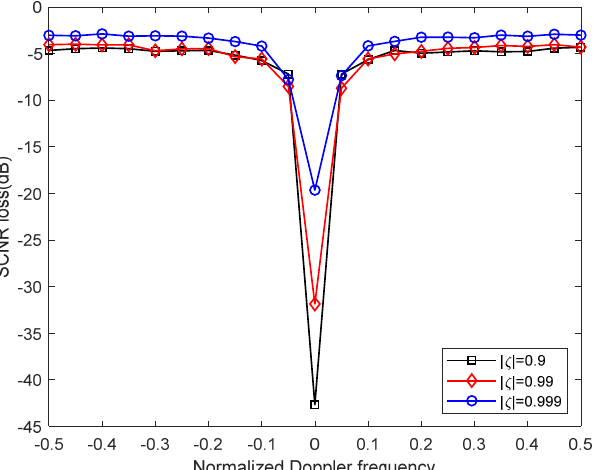
Figure 5. SCNR loss performance versus target Doppler frequency.